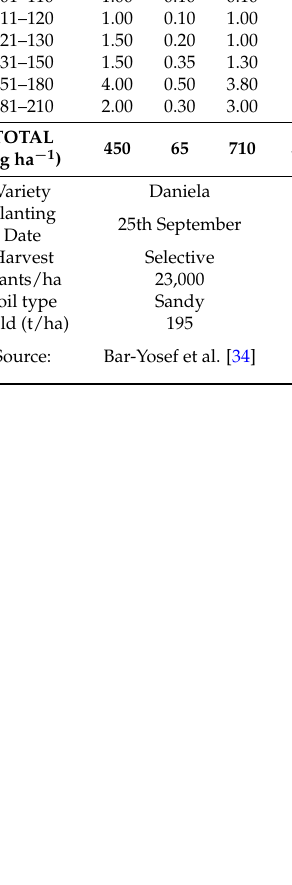
Figure 1. Relationship between crop growth (or yield) and nutrient soil concentration in the root zone. The maintaining of the minimum optimal nutrient concentration allows for reducing nutrient loss risk (e.g., NO 3 − leaching) without affecting crop produce and quality.